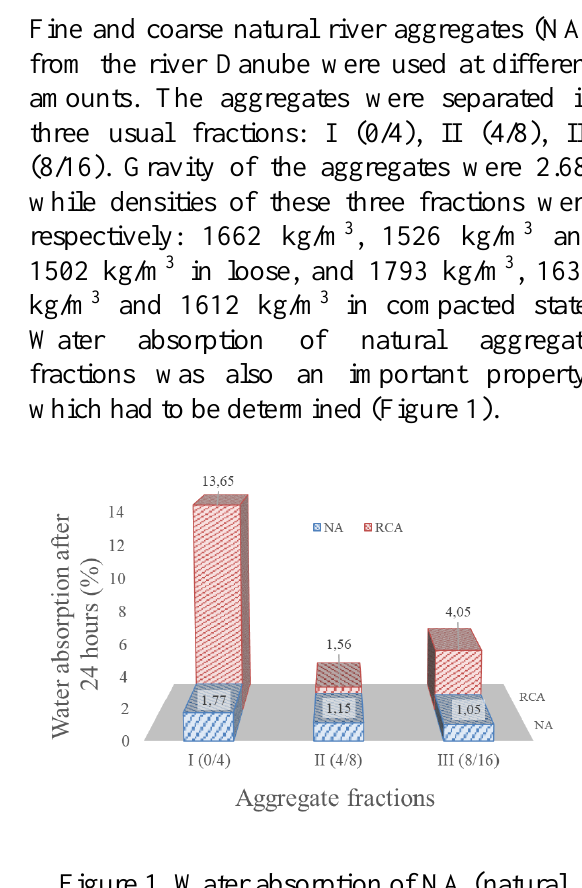
Figure 1. Water absorption of NA (natural aggregate) and RCA (recycled